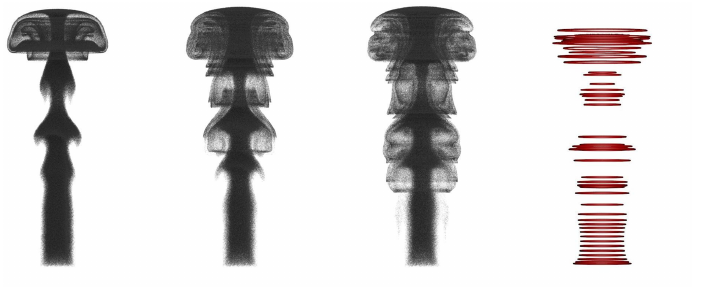
Figure 7. Simulation of a jet using different R of 0.00005, 0.000002, 0.0000005, and 0.000002 from left to right. The red lines in the right subfigure represent the vortex